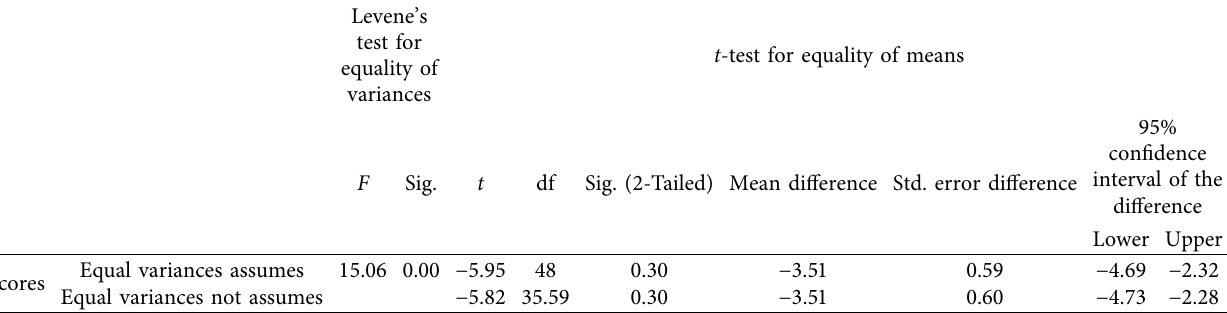
Table 4: Independent Samples t -test (the Posttest of Both